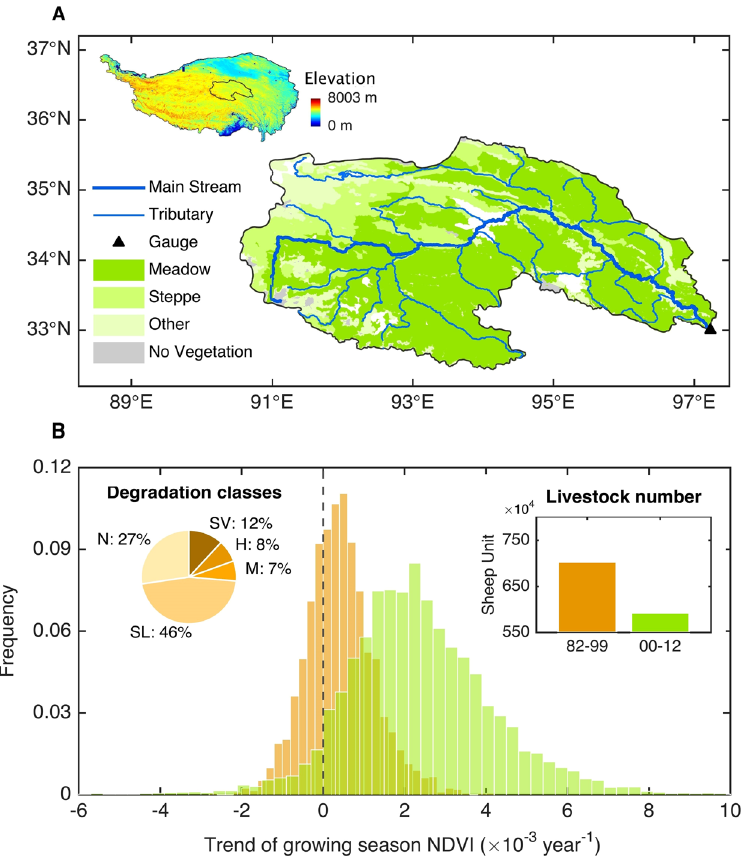
Figure 1. Grassland degradation and restoration in the headstream region of Yangtze River. ( A ) The spatial distribution of vegetation types in the catchment. Vegetation data is from the Institute of Botany, Chinese Academy of Sciences of 1:100 million Chinese Vegetation Map (2000). The maps in the figure is generated from MATLAB (R2014b). ( B ) Frequency distributions of growing-season (June to September) NDVI trends during pre-restoration (1982–1999) (in orange) and post-restoration (2000–2012) periods (in green). The left inset indicates the percentage for each of the five grassland degradation classes that took shape over the final three decades of the twentieth century, and the right inset shows the change in livestock number (in sheep unit) between pre-restoration and post-restoration period. Five different degradation classes are N (no degradation), SL (Slight degradation), M (Moderate degradation), H (Heavy degradation), and SV (Severe degradation), respectively. The NDVI trends during pre-restoration and post-restoration period are respectively based on GIMMS NDVI3g and MODIS, given the low data-quality of GIMMS NDVI in 2000 (Fig.